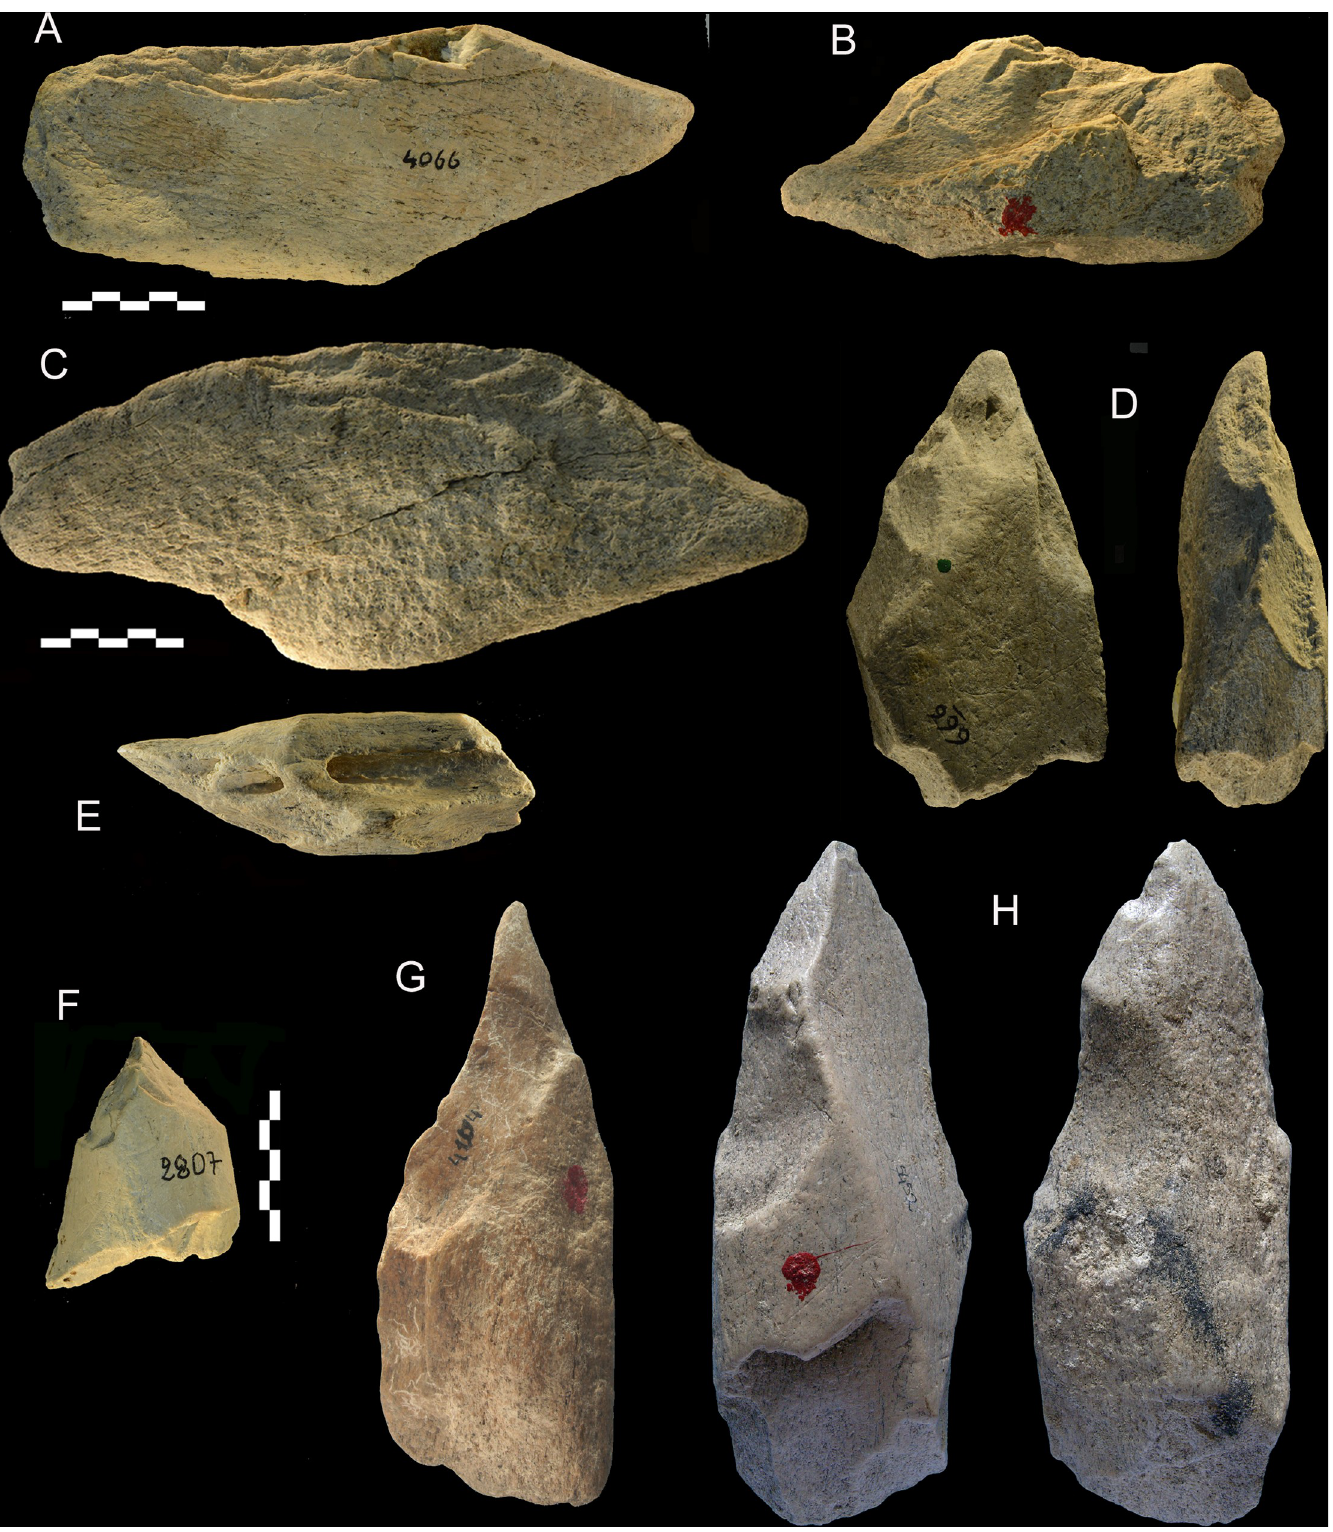
Fig 12. Castel di Guido, unifaces and pointed tools. (A-C) unifaces with a side scraper edge, catalogue numbers 4066, 6164, 4307. (D) pointed wedge (base is battered) catalogue number 666. (E-F) pointed tools on bovid diaphysis fragments, catalogue numbers 326, 2807. (G-H) pointed tools, catalogue numbers 4104, 5452.